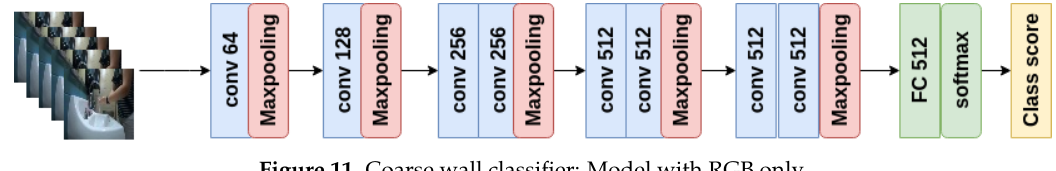
Figure 11. Coarse wall classifier: Model with RGB